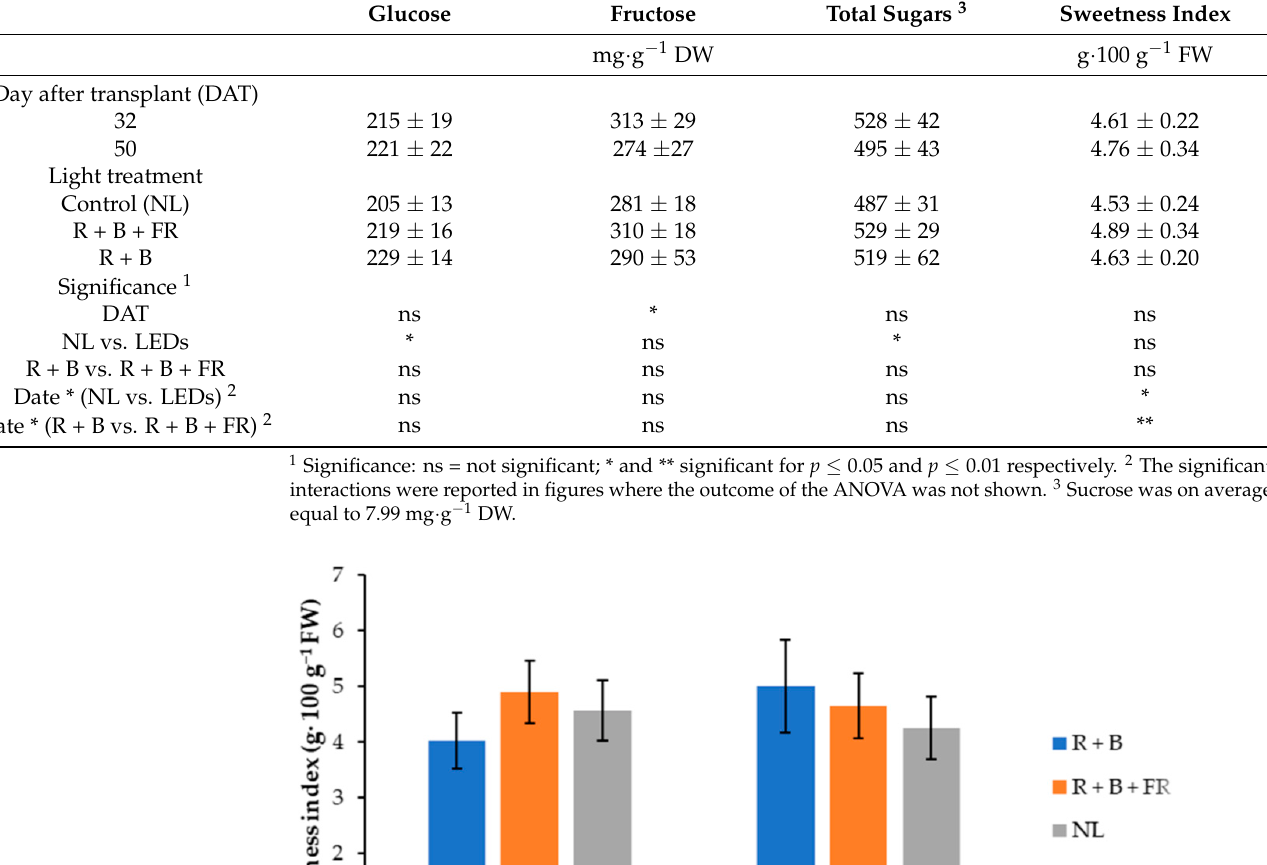
Table 4. Sugar content of the fruits of a landrace of Cucumis melo L. (“Carosello leccese”) in fruits from plants grown under solar light and two different light spectra. Values are average ± SD of three replications.